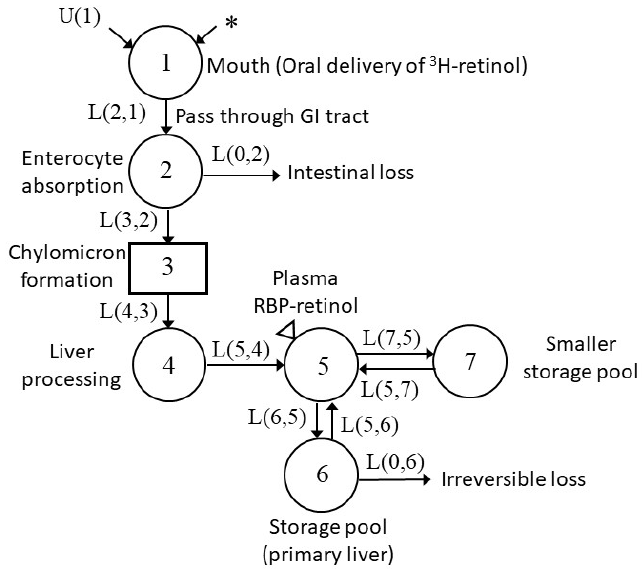
Figure 2. Conceptual model for VA tracer kinetics in rats. Each circle represents a different compartment, the rectangle represents a delay component. Arrows indicate the transfer of VA from one compartment to another compartment, where, for example, L(5,4) represents the fraction of VA in compartment 4 that is transferred to compartment 5 (plasma) per day. The asterisk indicates the site of the 3 H-labeled retinol dose entering the system, U(1) indicates the dietary intake of VA, and the triangle indicates the site of sample collection (plasma).